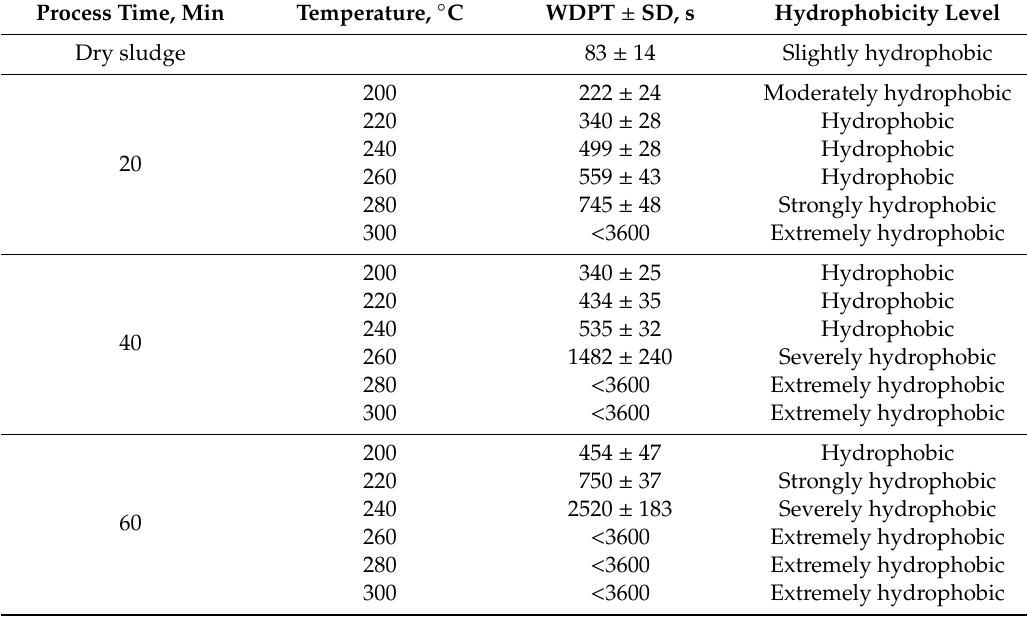
Table 2. Degrees of hydrophobicity of dry sludge and torrefied sewage sludge (SS) obtained from torrefaction of sewage sludge in six temperature variants, with three residence